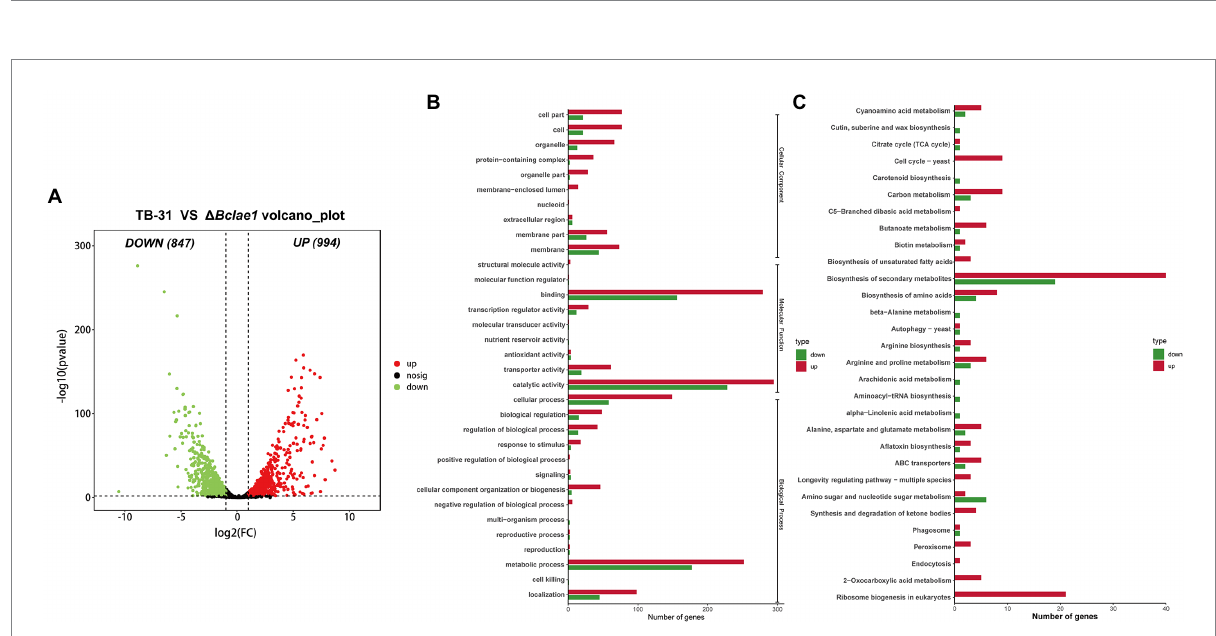
FIGURE 2 Genome-wide regulation of Bclae1 deletion in B. cinerea TB-31. (A) The number of differentially expressed genes between TB-31 and Δ Bclae1 mutant on day 6 of PDA culture. The criteria for the selection of DEGs were a log2 |fold change| ≥ 1, value of p < 0.05, and RPKM of at least one sample larger than 1. (B,C) Counts of differentially expressed genes significantly enriched to GO function classes and KEGG pathways,